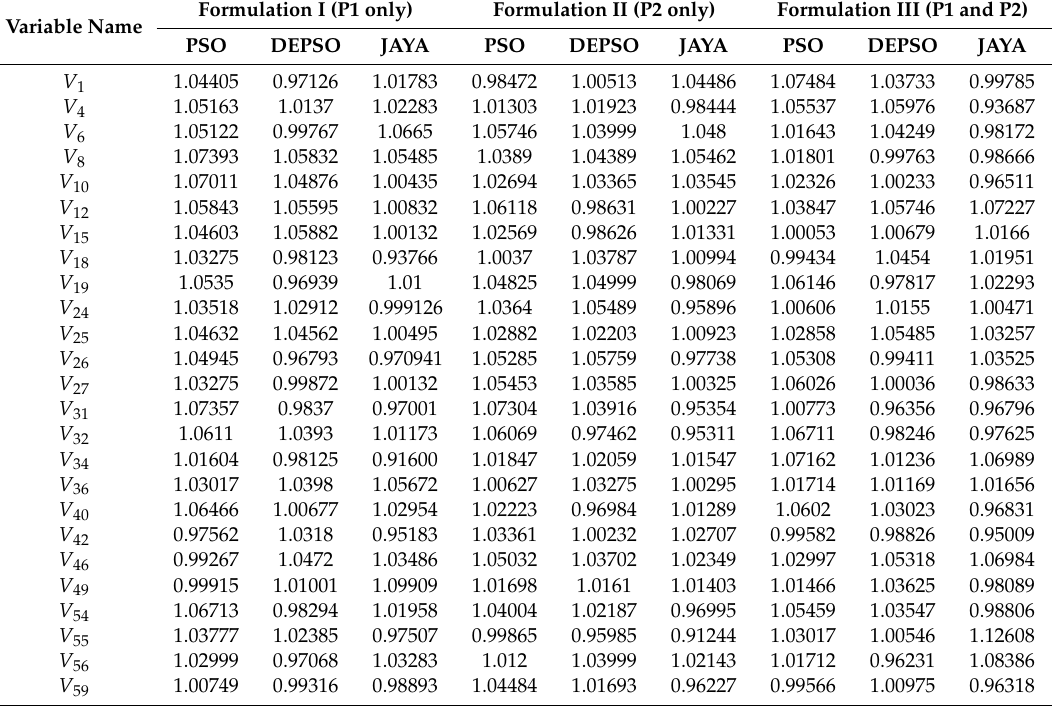
Table A1. Optimal control variables (continuous only) for IEEE 118-bus using di ff erent